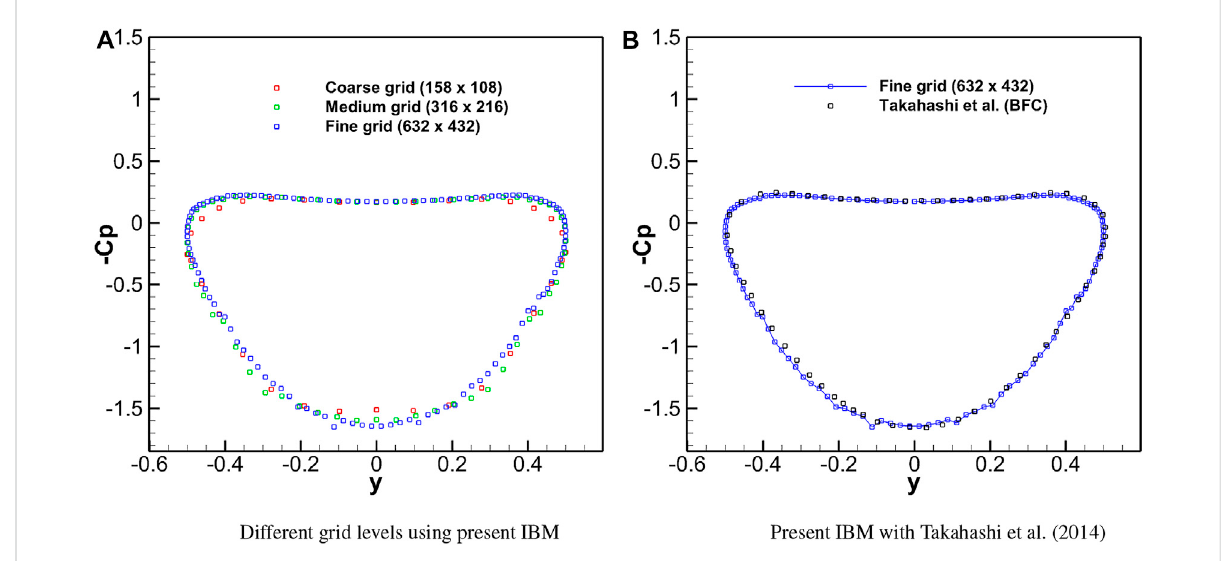
FIGURE 20 Comparison of surface pressure distribution for the supersonic fl ow over a cylinder. (A) Different grid levels using present IBM. (B) Present IBM with Takahashi et al. (2014).